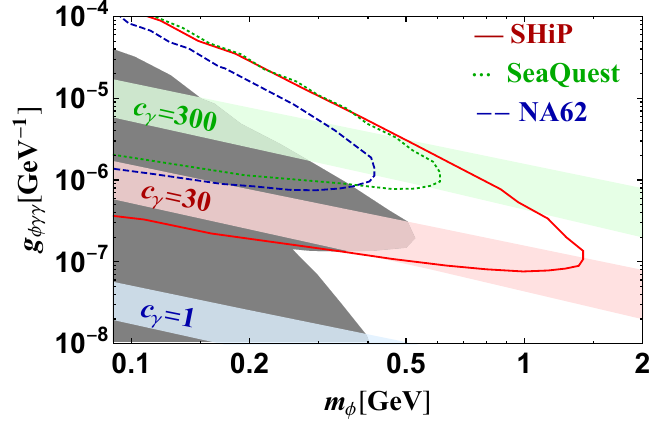
Figure 3 . The parameter region predicted by the ALP inflation ( n = 2) with coupling to photons plane. The green, red, and blue bands correspond to c in the m φ − g φγγ respectively, from top to bottom. The red solid line denotes the projected sensitivity reach of the SHiP experiment. The green dotted line and blue dashed line denotes the sensitivity of SeaQuest and NA62, respectively. The gray region is excluded by experiments and SN1987A. Both the sensitivity reach and excluded regions are adopted from ref.